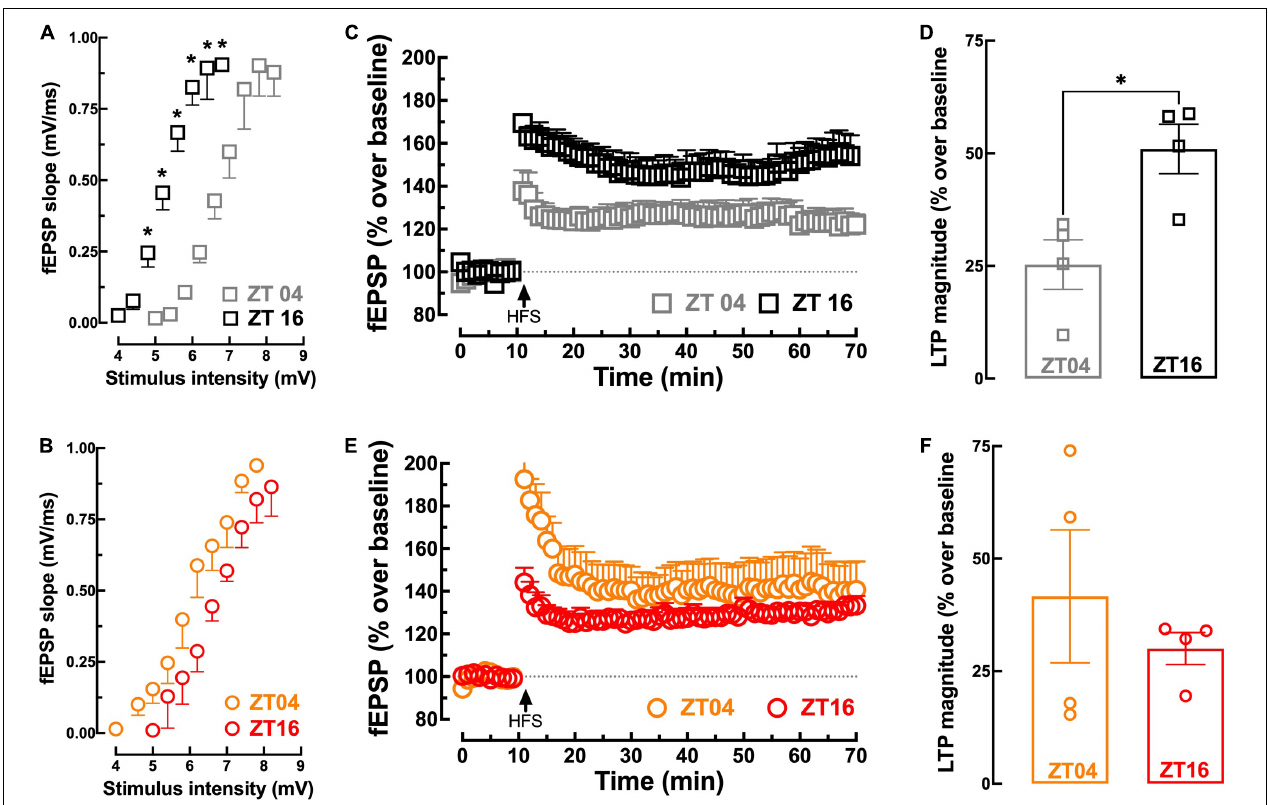
FIGURE 2 | Comparison of synaptic transmission and plasticity in hippocampal slices from non-Tg and 3xTg-AD mice collected near ZT04 (inactive phase) and ZT16 (active phase). The input/output curves presenting the field excitatory post-synaptic responses (fEPSP, measured as their slope recorded in the dendritic field of CA1 pyramidal neurons), with increasing stimulation intensity of the afferent Schaffer fibers, show that there was a circadian difference of synaptic transmission with a greater synaptic efficiency at ZT16 than at ZT04 in non-Tg mice (A) , which was not present in 3xTg-AD mice (B) . The time course of variation of fEPSP responses (expressed as percentage variation of the average basal values) (C) shows that a high-frequency stimulation (HFS, 100 Hz for 1 s) train triggered a persistent increase of the fEPSP response (long-term potentiation, LTP) with a magnitude larger at ZT16 than at ZT04 in slices from non-Tg mice (C) , which average values are displayed in the bar graph (D) . This circadian variation was not present in 3xTg-AD mice, as illustrated in the time course (E) and corresponding average values of LTP magnitude (F) . Data are mean ± SEM of 4–5 mice per group, as indicated by the individual symbols (non-Tg at ZT04 in gray squares, non-Tg at ZT16 in black squares, 3xTg-AD at ZT04 in orange circles, and 3xTg-AD at ZT16 in red circles). Statistical analysis: * p < 0.05 vs. other ZT or between indicated bars using a Student’s t -test.